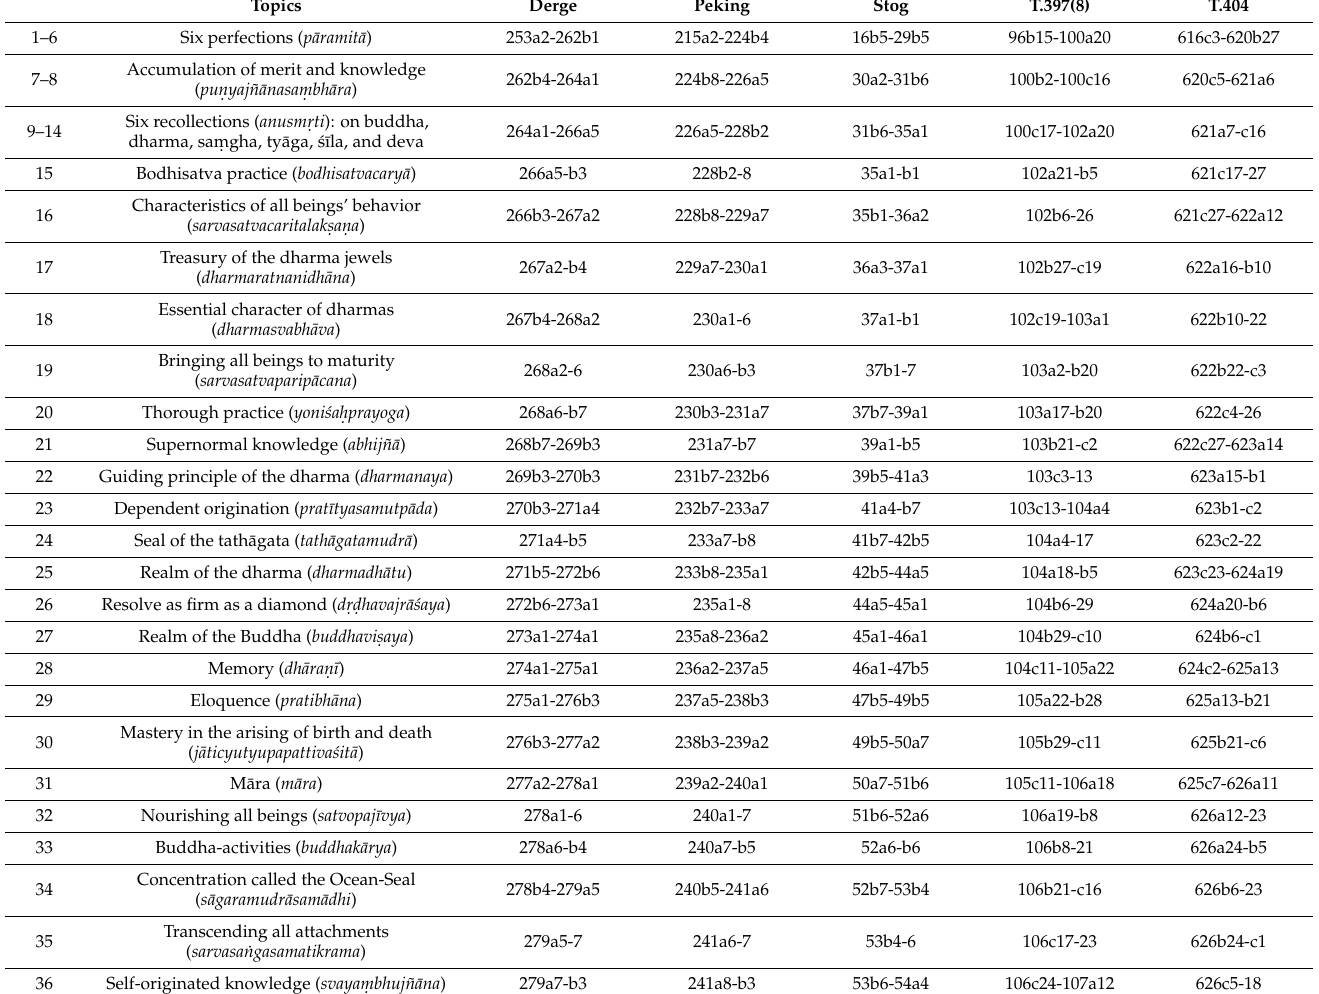
Table 2. Topics of the thirty-six questions and answers between Gaganagañja and the